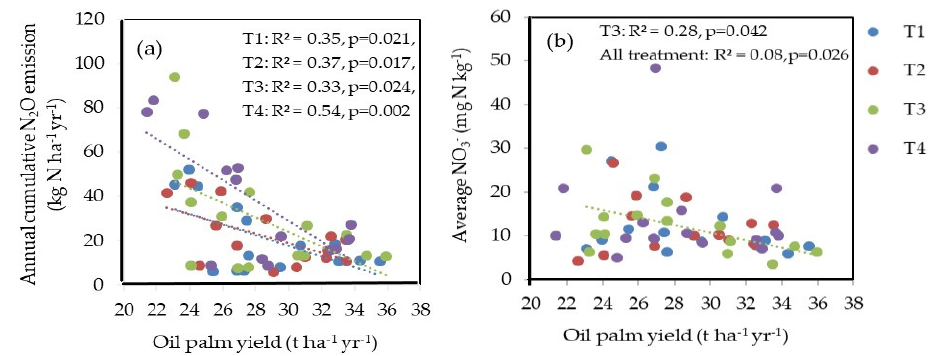
Figure 4. Relationships between oil palm yields and annual cumulative N 2 O emissions ( a ); and between oil palm yields and NO 3 − ( b ) for each treatment.